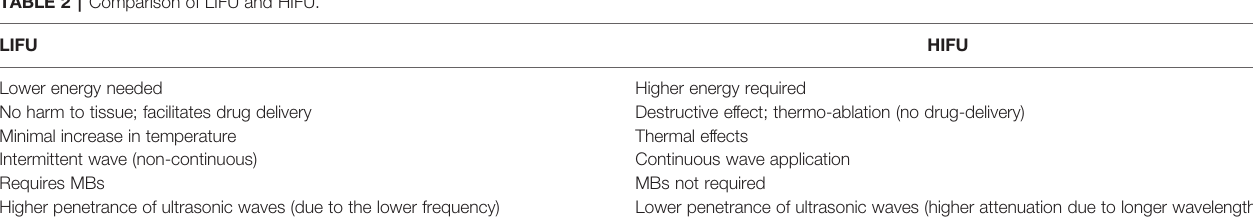
TABLE 2 | Comparison of LIFU and